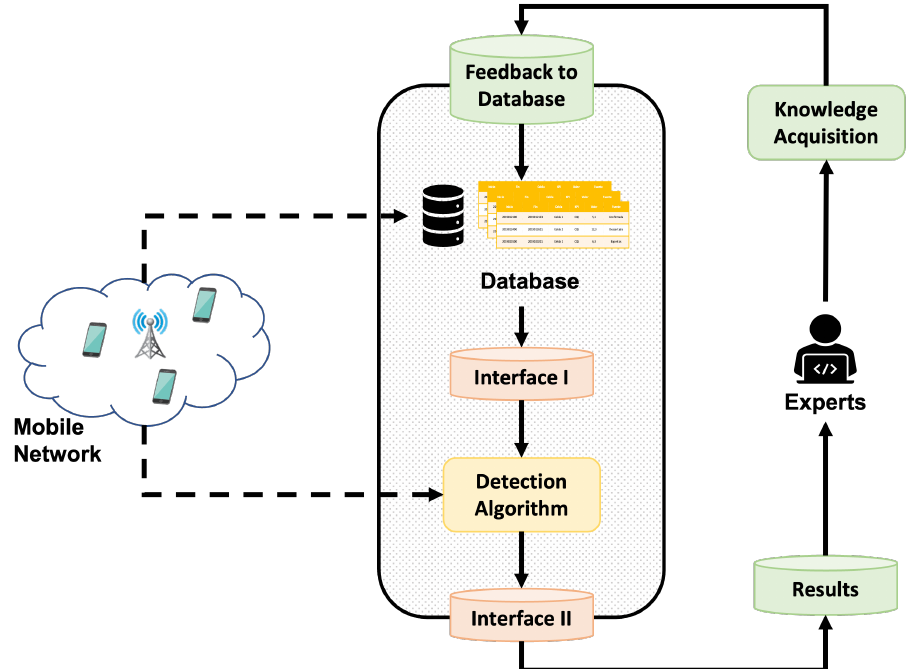
Figure 1. Blocks diagram of proposed